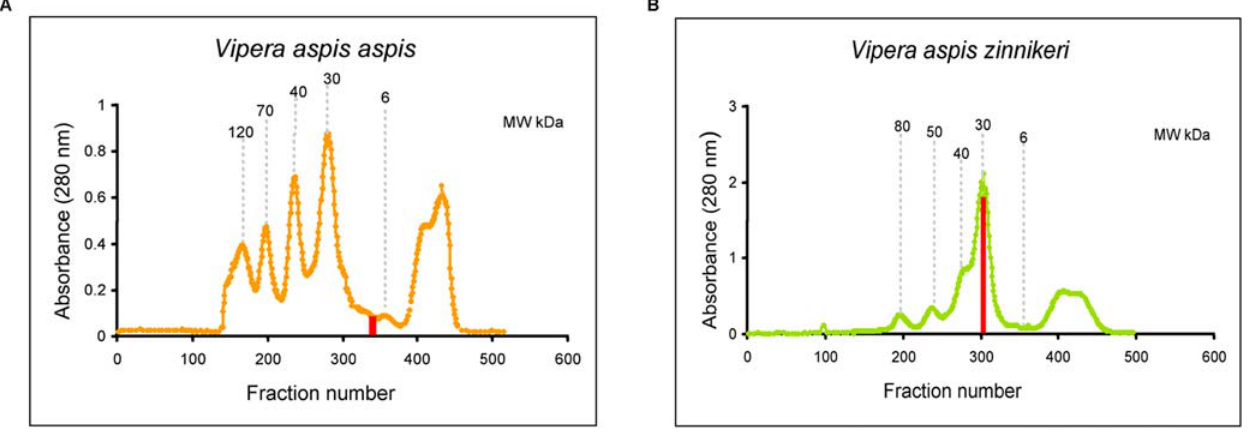
Figure 5. Isolation of PLA 2 fractions from pooled Vaaand pooled Vazvenoms on Sephadex G100 Superfine column. (A) Pooled Vaa and (B) pooled Vaz were fractionated on Sephadex G100 superfine as described in the Material and Methods section. Fractions containing PLA 2 activity are shown in red.